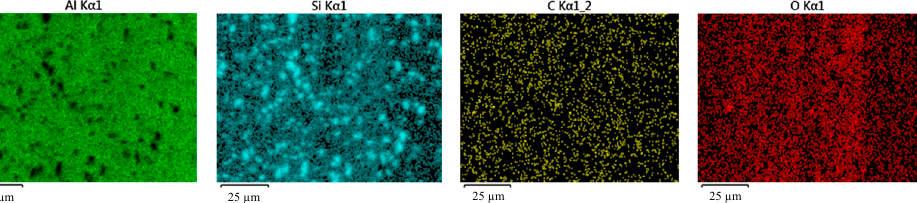
Figure 7. EDS elemental mapping of the surface composite.